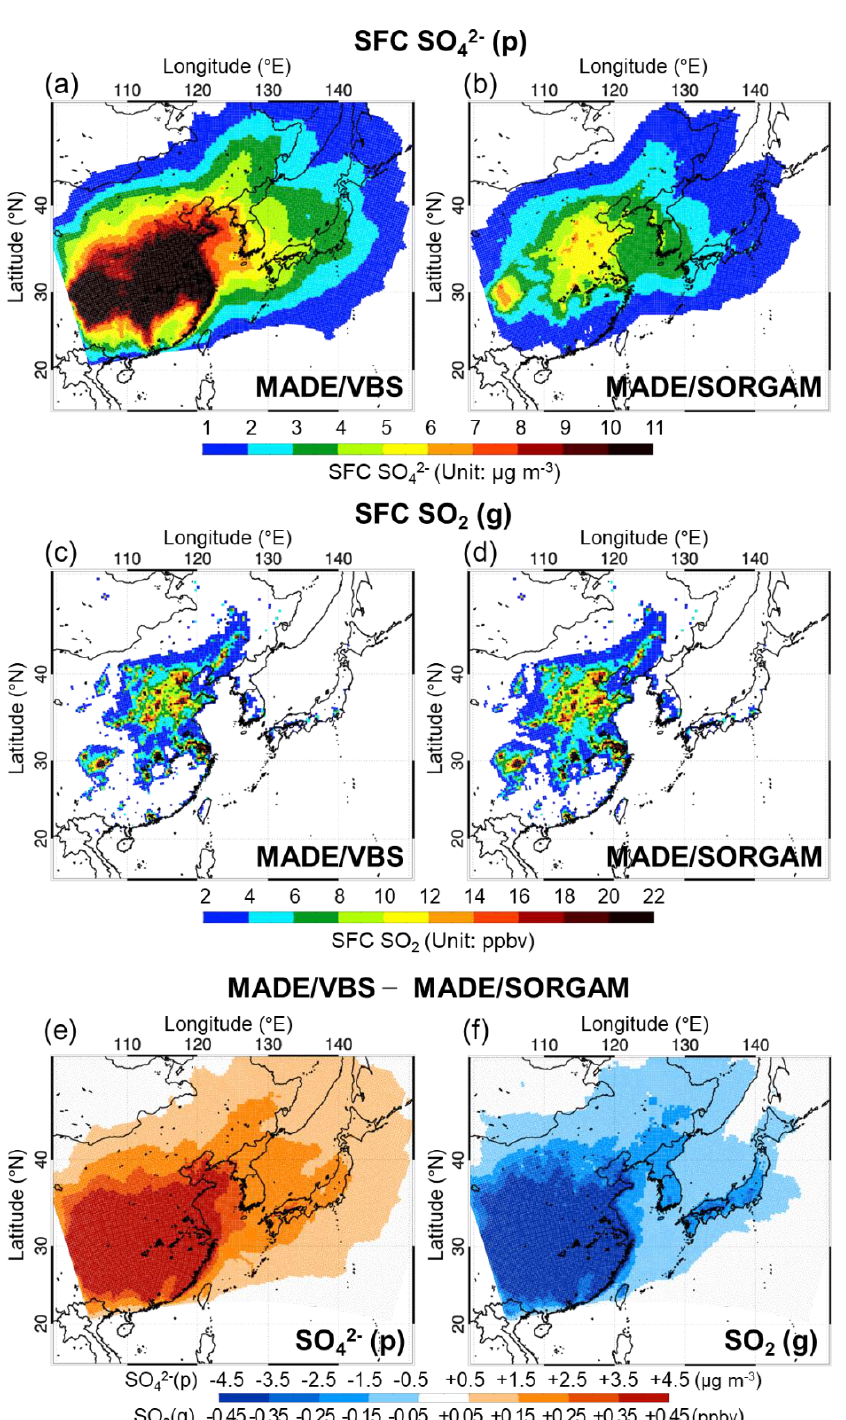
Figure 6. Comparisons of horizontal distributions for sulfate ( a , b ), SO 2 gas concentrations ( c , d ), and differences ( e , f ) between two modules, MADE/VBS (left panel) and MADE/SORGAM (right panel), for sulfate (SO 42 − ) and SO 2 , respectively.